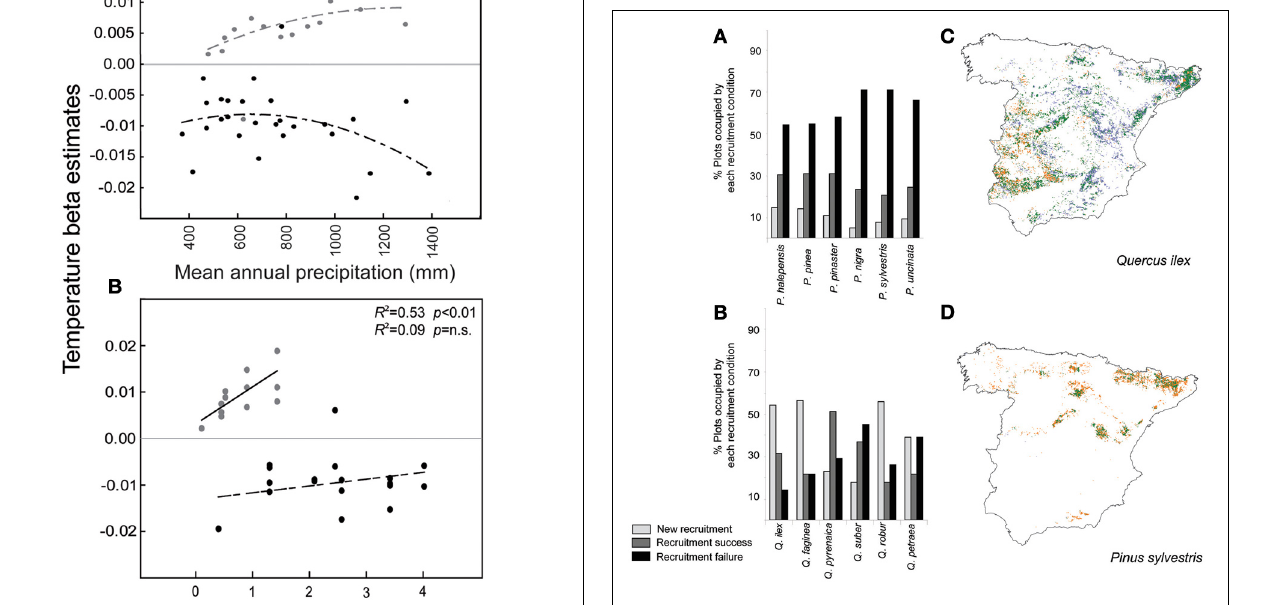
FIGURE 2 | Contrasting large-scale trends in tree recruitment observed in the Iberian peninsula for small saplings (height < 30cm) in Conifers ( Pinus ) and Angiosperm trees ( Quercus ). (A) Variation in the percentage of plots with recruitment success (gray), recruitment failure (black) and new recruitment areas (plots without adult trees of the focal species in which small recruits or resprouts were detected) in Pinus species; (B) Variation in the percentage of plots with recruitment success (gray), recruitment failure (black) and new recruitment areas in Quercus species. (C) Spatial trends in recruitment for the dominant species Quercus ilex . Blue areas indicate new recruitment areas (i.e., areas with recruits but absence of adult trees), orange areas illustrate recruitment failure and green areas illustrate recruitment success (i.e., areas characterized by the presence of both adult and small saplings). (D) Spatial trends in recruitment for Pinus sylvestris . Differences between recruitment trends in Pinus and Quercus were significant (see Carnicer et al., 2013a for a detailed statistical test. Average proportion of plots with recruitment failure: F = 16 . 64, P = 0 . 002; average proportion of plots with new recruitment: F = 35 . 04, P = 0 . 0001). Data were obtained from the Spanish National Forest Inventory, consisting in a regular grid of circular plots at a density of 1 plot/km 2